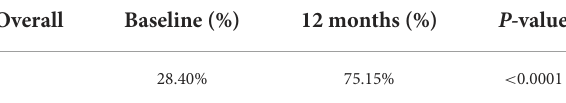
TABLE 9 Percentage of subjects with a null or low-risk consumption in Group 2.